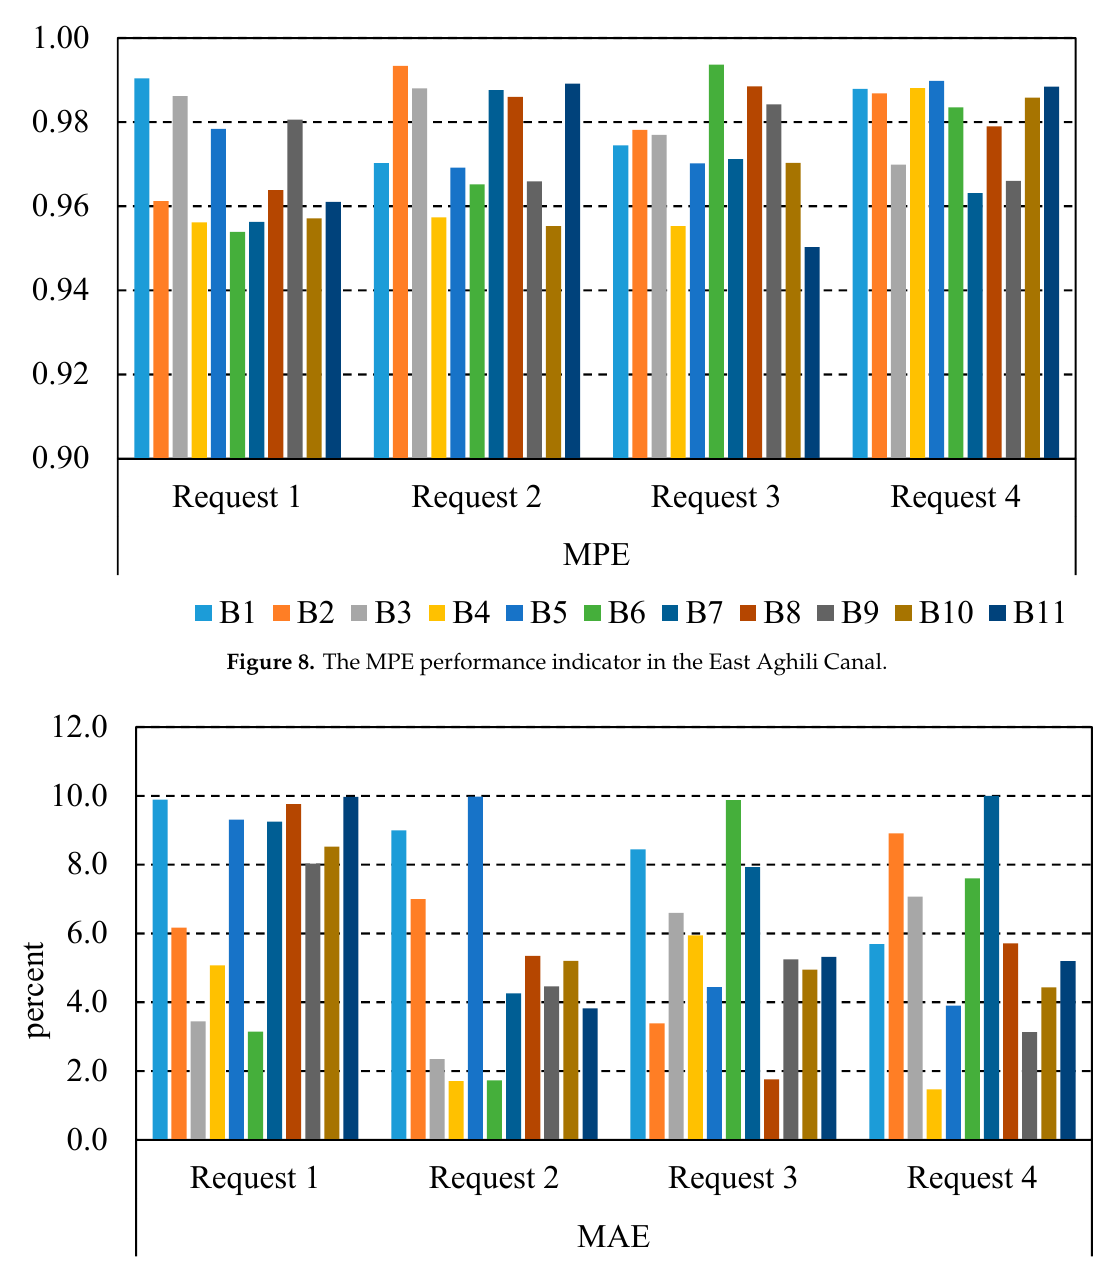
Figure 10. The absolute magnitude of error (IAE) performance indicator in the East Aghili Canal. Therefore, the water level does not leave the dead band, and performance is acceptable. Water delivery to the turnouts was accurate, and water depths fluctuations were low. In addition, the investigated water depth and delivery indicators for the canal are illustrated in Figure 11. As shown, a “good” performance is obtained according to the performance criteria presented in [22]. Overall, all the above values and corresponding figures show that FSL can be generalized using the GLQ model. According to the rewards, corresponding relative errors, and performance indicator values, it can be concluded that the FSL generalization is possible in irrigation canals, i.e., it is possible to train the system with typical situations, so a good performance can be expected in practice. Moreover, the system can learn new things in the future.